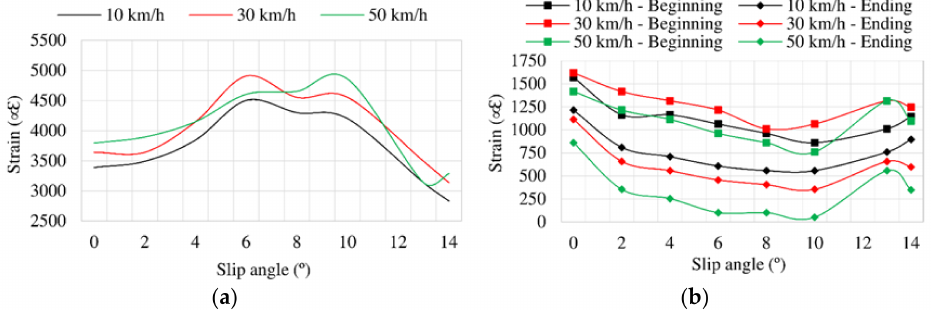
Figure 9. ( a ) Maximum strain peaks in channel 2 ( ε x ) at 0.8 bar, 750 N; ( b ) Maximum strain peaks in channel 3 ( ε y1 ) at 0.8 bar, 750